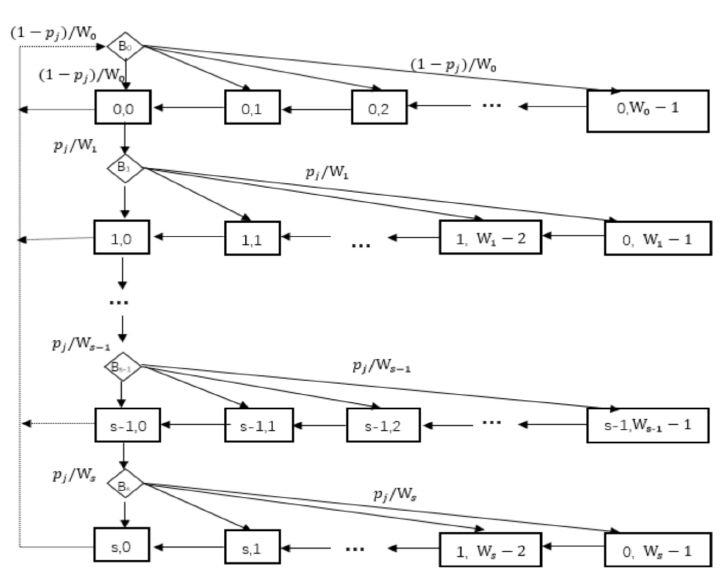
Figure 2. Collision avoidance